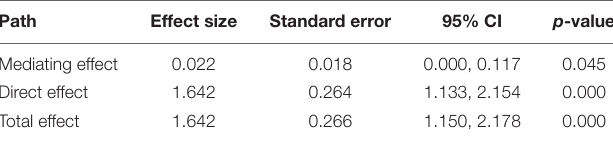
TABLE 7 | Mediating